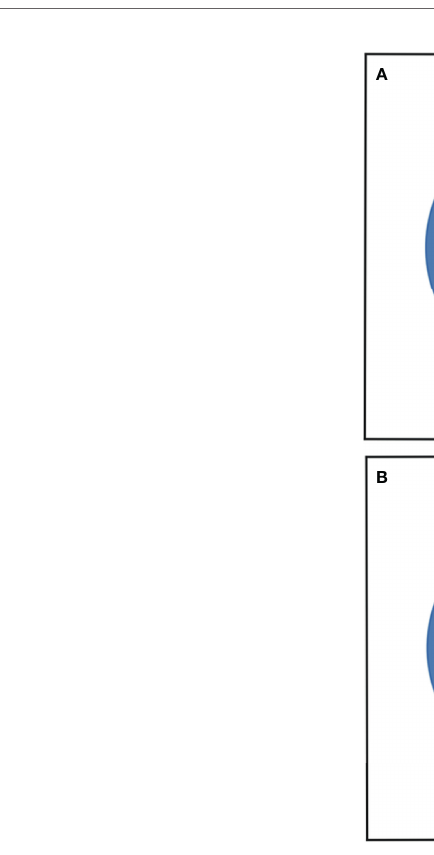
FIGURE 3 | Venn diagram of differential metabolites between TB group vs HC group and TB group vs DC group. (A) Up-regulated metabolites; (B) Down-regulated